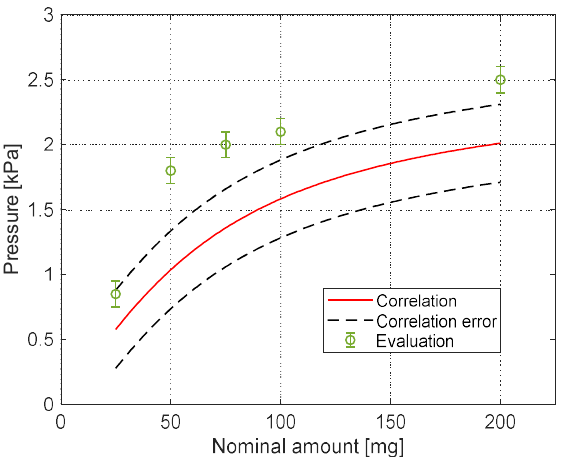
Figure 13. Comparison between the modelled and experimental pressure.